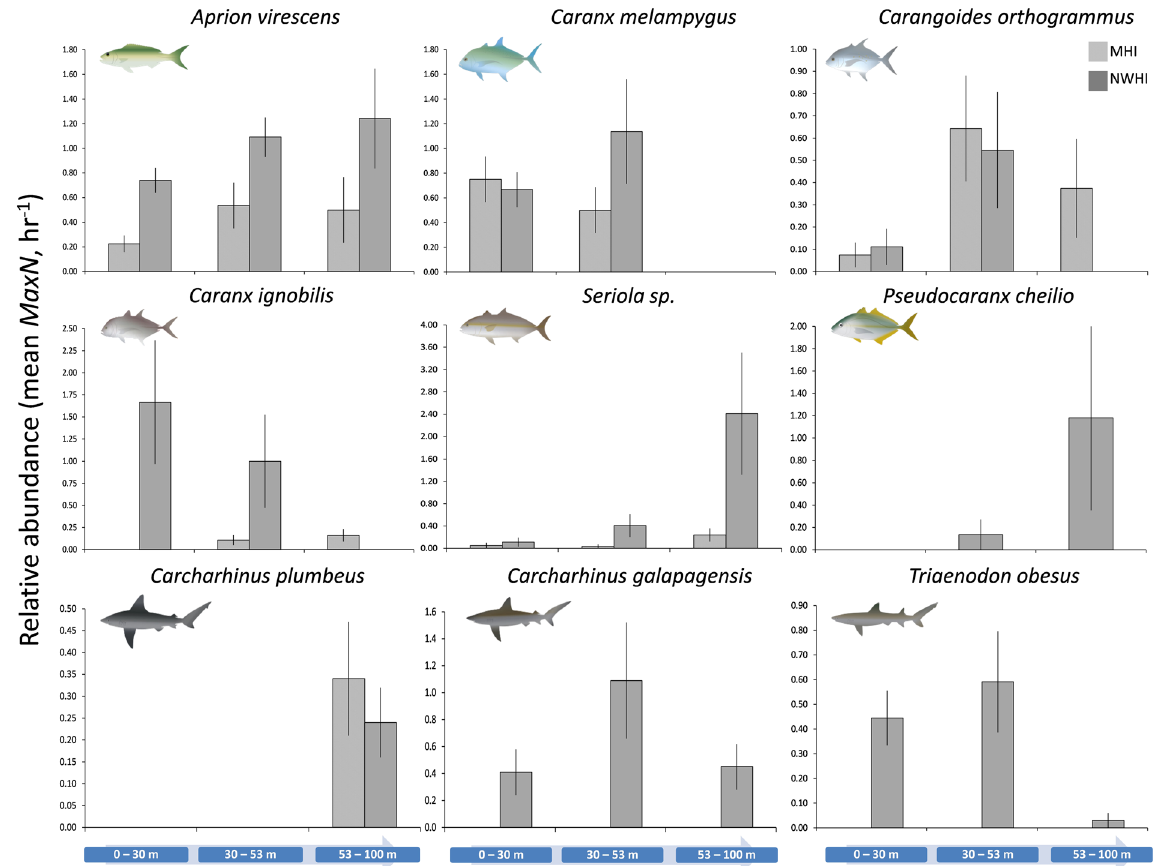
Figure 5. Mean relative abundance (Mean MaxN , hr − 1 ± SE) of roving predator species identified in SIMPER analyses across regions and depth strata (habitats pooled). Depth is ordered in increasing intervals, with all habitats pooled. Light grey = MHI, dark grey = NWHI. Note the differences in scales along the y-axis.